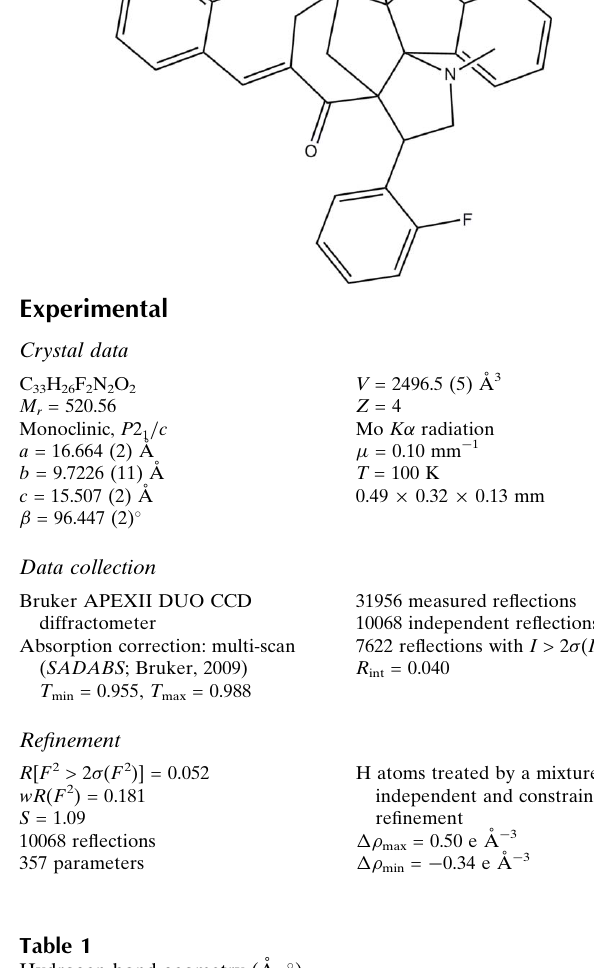
Hydrogen-bond geometry (A˚ , (cid:2) ). Cg 1 and Cg 2 are the centroids of the C14–C18/C23 and C1–C6 rings,